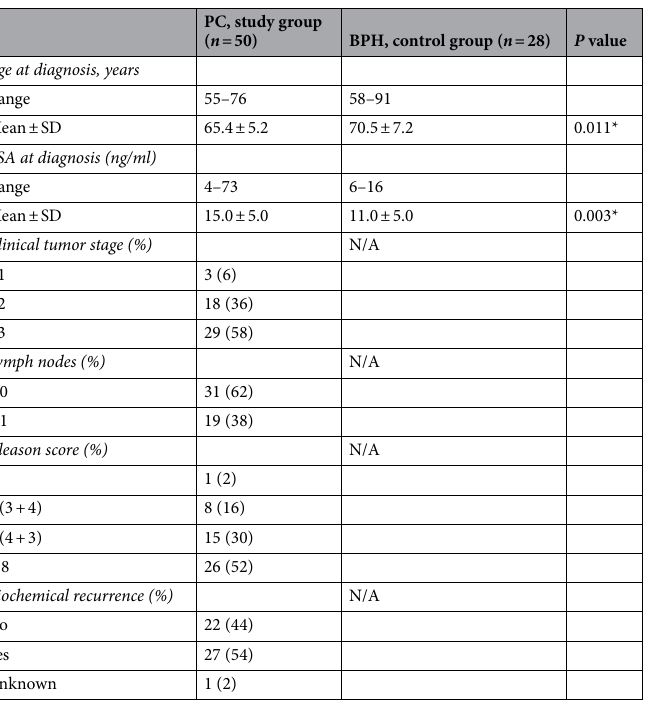
Table 1. Analytical data of all participants in the study. n : number of subjects. SD: standard deviation. N0: there is no evidence of cancer in the regional lymph nodes. N1: cancer has spread to lymph nodes. N/A: not applicable. * Significant difference at P <